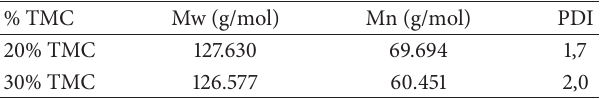
Table 1: Molar mass of